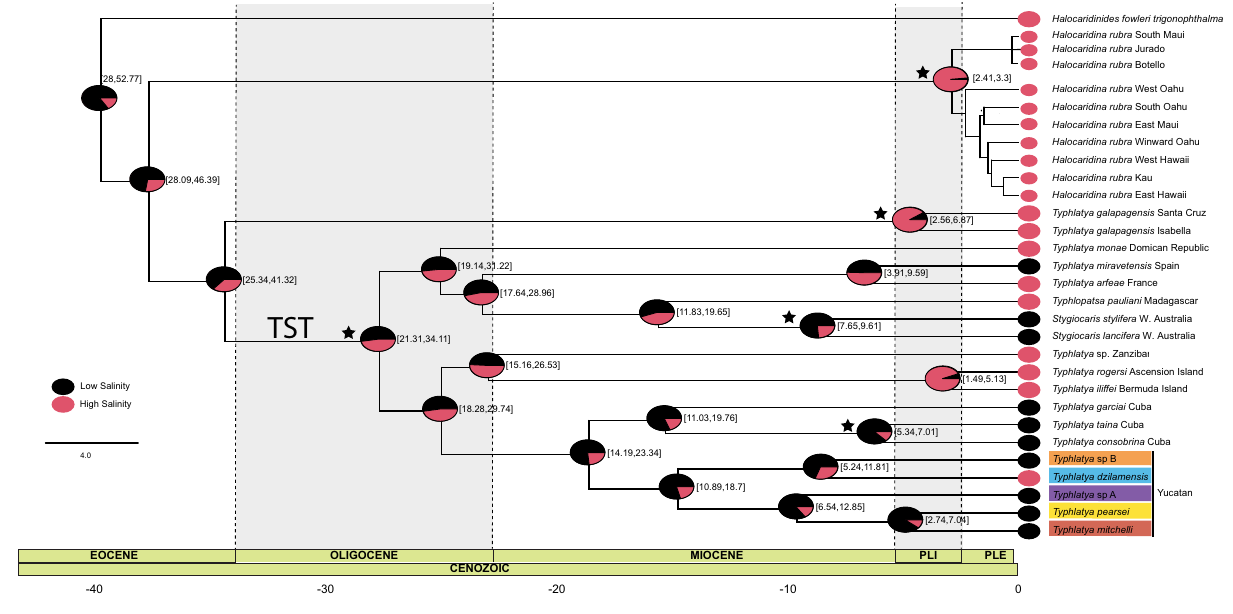
Figure 6. Chronogram showing divergence estimates (in brackets; Mya, 95% high posterior density limits (HPD) as confidence intervals), based on a relaxed, lognormal clock, Yule diversification model, 5 gene partitions (COI + CYB + H3, 1st codon/COI + CYB, 2nd codon/16S/28S/18S + H3, 2nd codon) and 5 independent clock models for the anchialine Atyidae clade. Stars at nodes indicate calibration points used in BEAST2 analyses. Stochastic mapping of salinity trait evolution is visualized with the probability density of each state at internal nodes. Equal rates and unequal estimation (i.e., 0.75 likelihood of a low salinity ancestor) was assumed at the root. Circles at tips denote salinity preferences of lineages, low salinity (black; state 1) and high salinity (red; state 2). Uncertainty of ancestral states indicated at